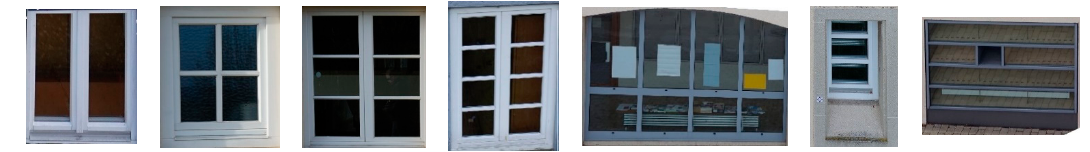
Figure 2. The different window types considered in this study.